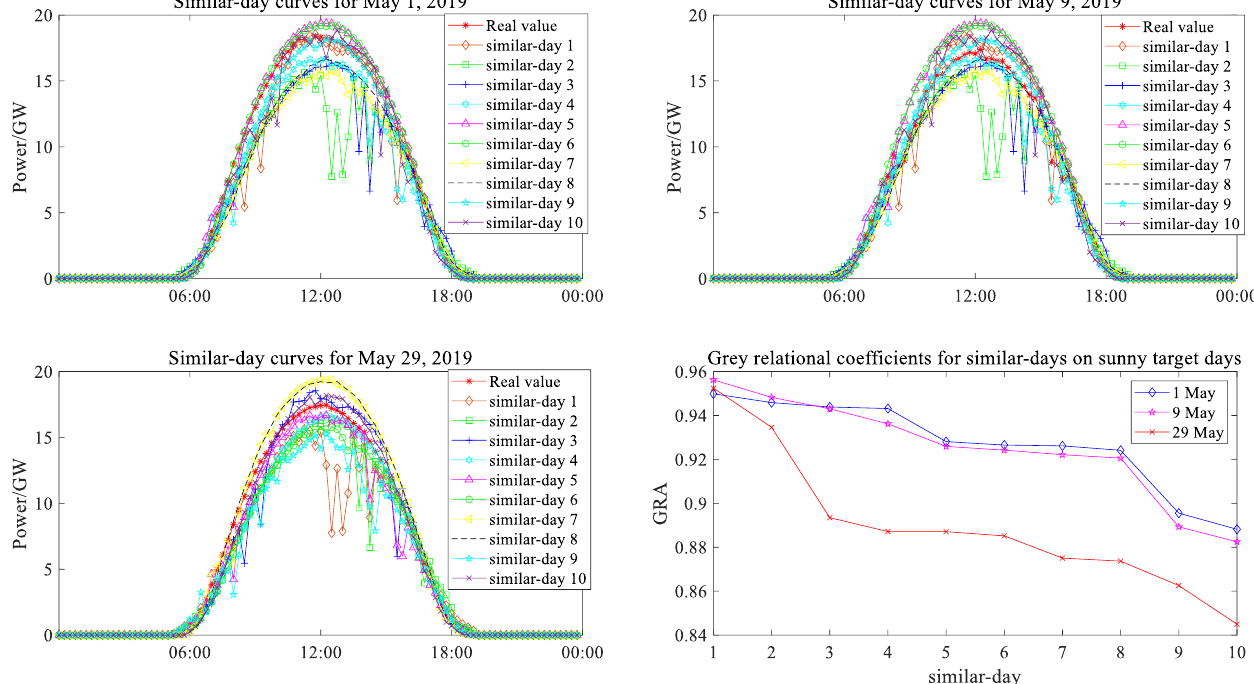
Figure 5. Similar -day curves for sunny target days and their grey relational coefficients.